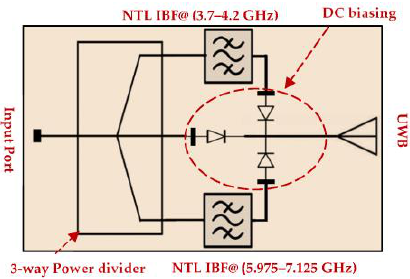
Figure 1. Future project: compact reconfigurable 5G and UWB antenna.